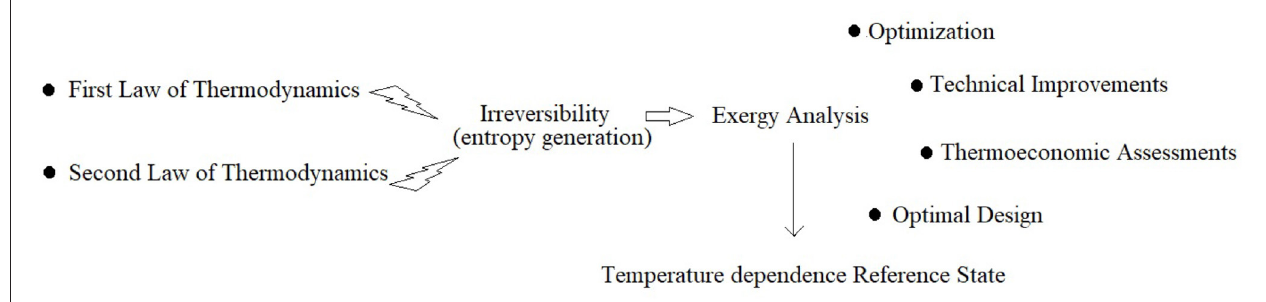
FIGURE 1 | The methodological diagram is represented. It highlights that the basis of any technological analysis are the first and second law of thermodynamics. Irreversibility is a natural character of any process. It is evaluated by the entropy generation, which is also the fundamental quantity of the exergy analysis for optimization. This approach is improved by introducing also the income index for a more human-oriented analysis on sustainability. The limit of the approach is represented by the temperature dependence of the definition of exergy, which must be taken into account for any country and